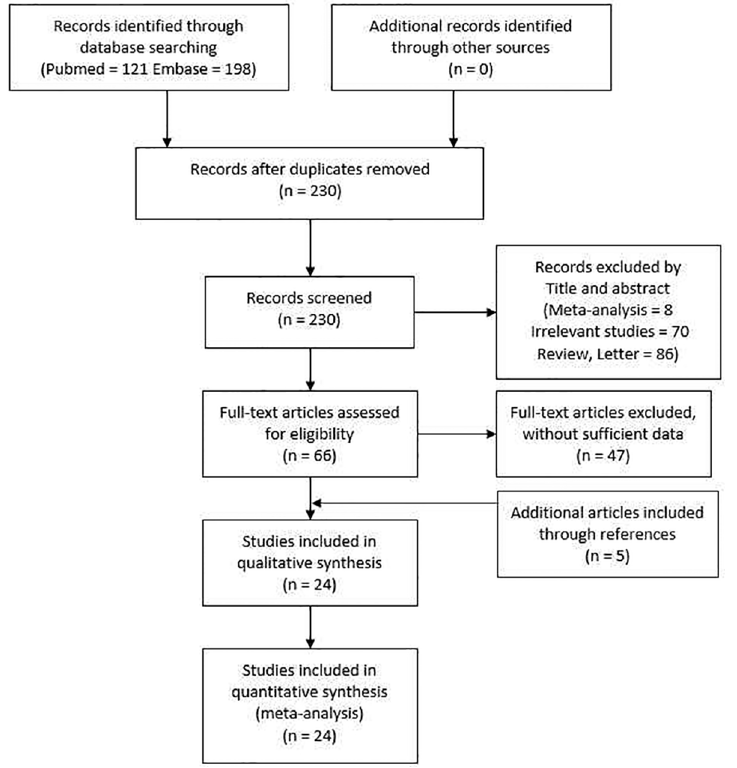
Fig 1. Flow diagram of the study selection process.